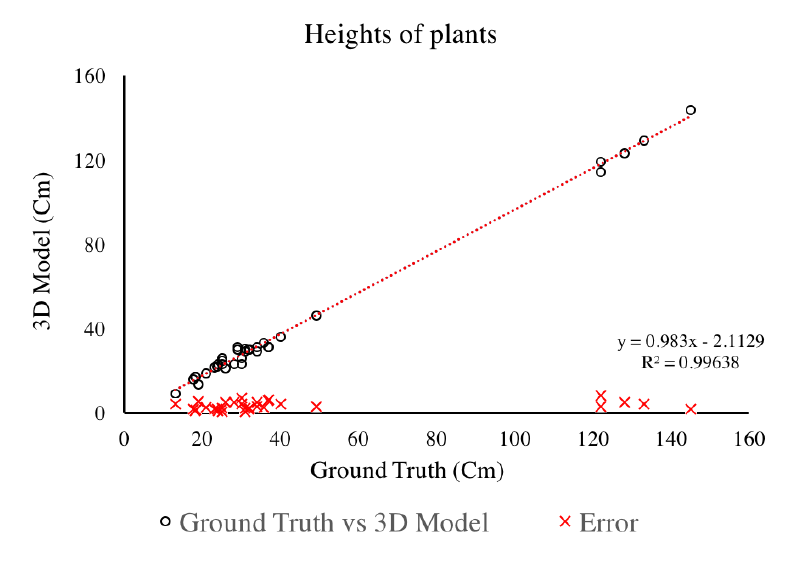
Figure 7. Relationship of plant height measured manually and plant height extracted from the 3D Model created using RGB images captured by